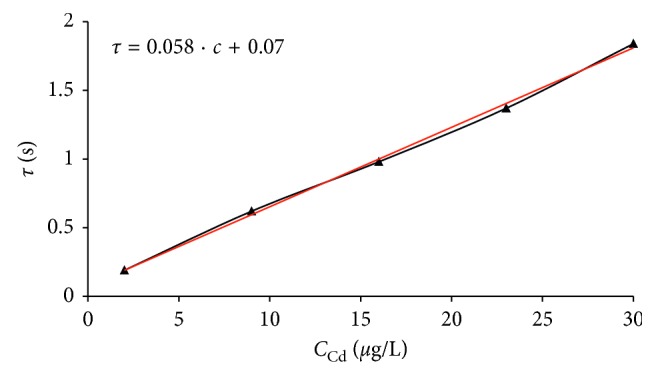
Linearity of cadmium analytical signal (tdep = 300 s; trp = 60 s; iR = 15.1 μA; Q = 13.2 ml/min).